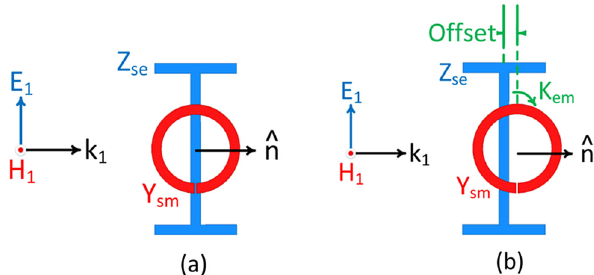
Figure 4: Omega bianisotropic particle (reprinted with permission from Ref. [61]). (a) The Omega bianisotropic particle geometry. (b) Induced dipole moments underelectricexcitation.(c)Induceddipole moments under magnetic excitation.